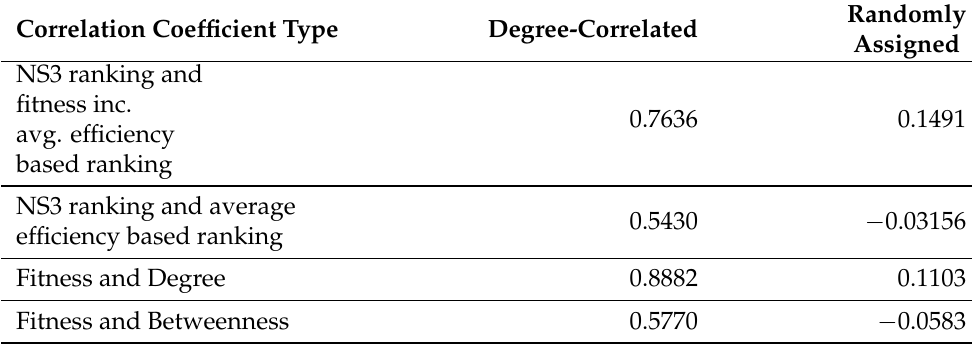
Table 9. Ranking correlations for the scale-free topology, when the node fitness is distributed in a degree-correlated and a random